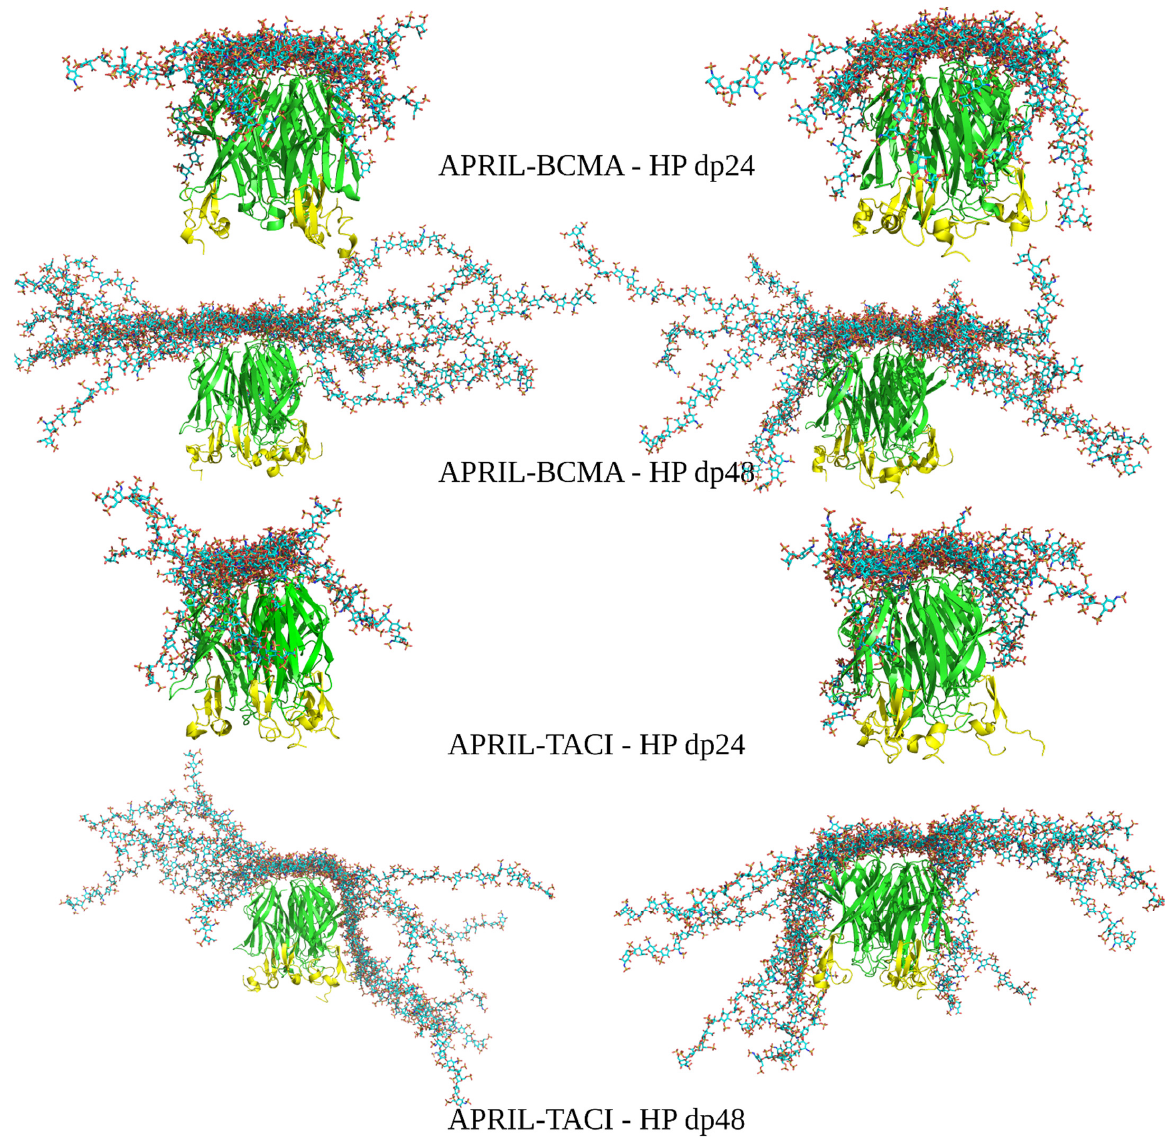
Figure 4. The most energetically favorable ( left ) and manually chosen ( right ) structures of the APRIL–BCMA and APRIL– TACI complexes with HP dp24 and HP dp48 after refinement procedure (HP in licorice representation, cyan color; APRIL (green color) and BCMA/TACI (yellow color) are in cartoon representation.